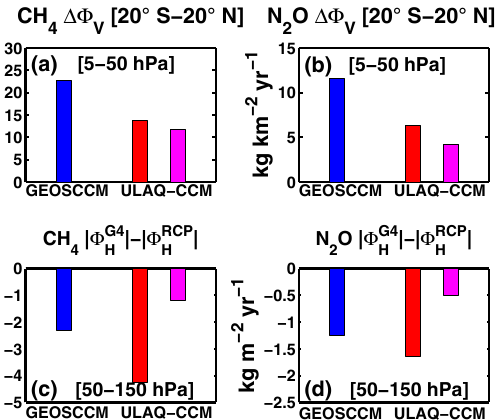
Figure 3. G4-RCP4.5 anomalies of (a, b) vertical and (c, d) hori- zontal mass fluxes of (a, c) CH 4 and (b, d) N 2 O (years 2040–2049 time average). Vertical mass fluxes in panels (a, b) (defined as in Fig. 2) are averaged over the tropics (20 ◦ S–20 ◦ N) in the 5–50hPa vertical layer, with GEOSCCM results in blue and ULAQ-CCM re- sults in red and magenta for cases (a) and (c) as in Table 1, respec- tively (kgkm − 2 yr − 1 ). Horizontal mass fluxes in panels (c, d) (de- fined as vρ , with v and ρ the 3-D meridional wind component and mass concentration of CH 4 and N 2 O, respectively) are averaged (in absolute values) over the extratropics (90–20 ◦ S and 20–90 ◦ N) in the 50–150hPa vertical layer, with model results as in panels (a, b) (kgm − 2 yr − 1 ).